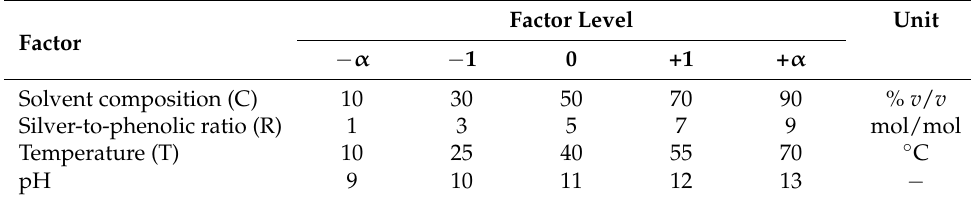
Table 1. Actual and coded levels of factors for the CCD.